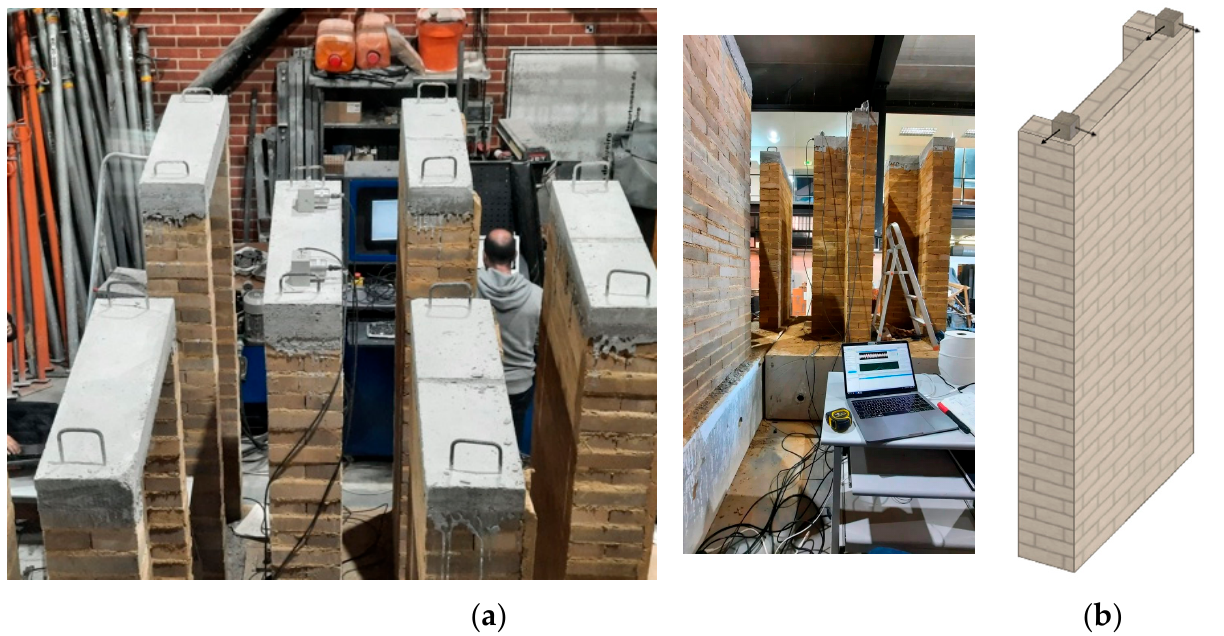
Figure 7. Dynamic identification test: ( a ) sensors placed during one setup and ( b ) axonometric scheme of the location of the sensors.